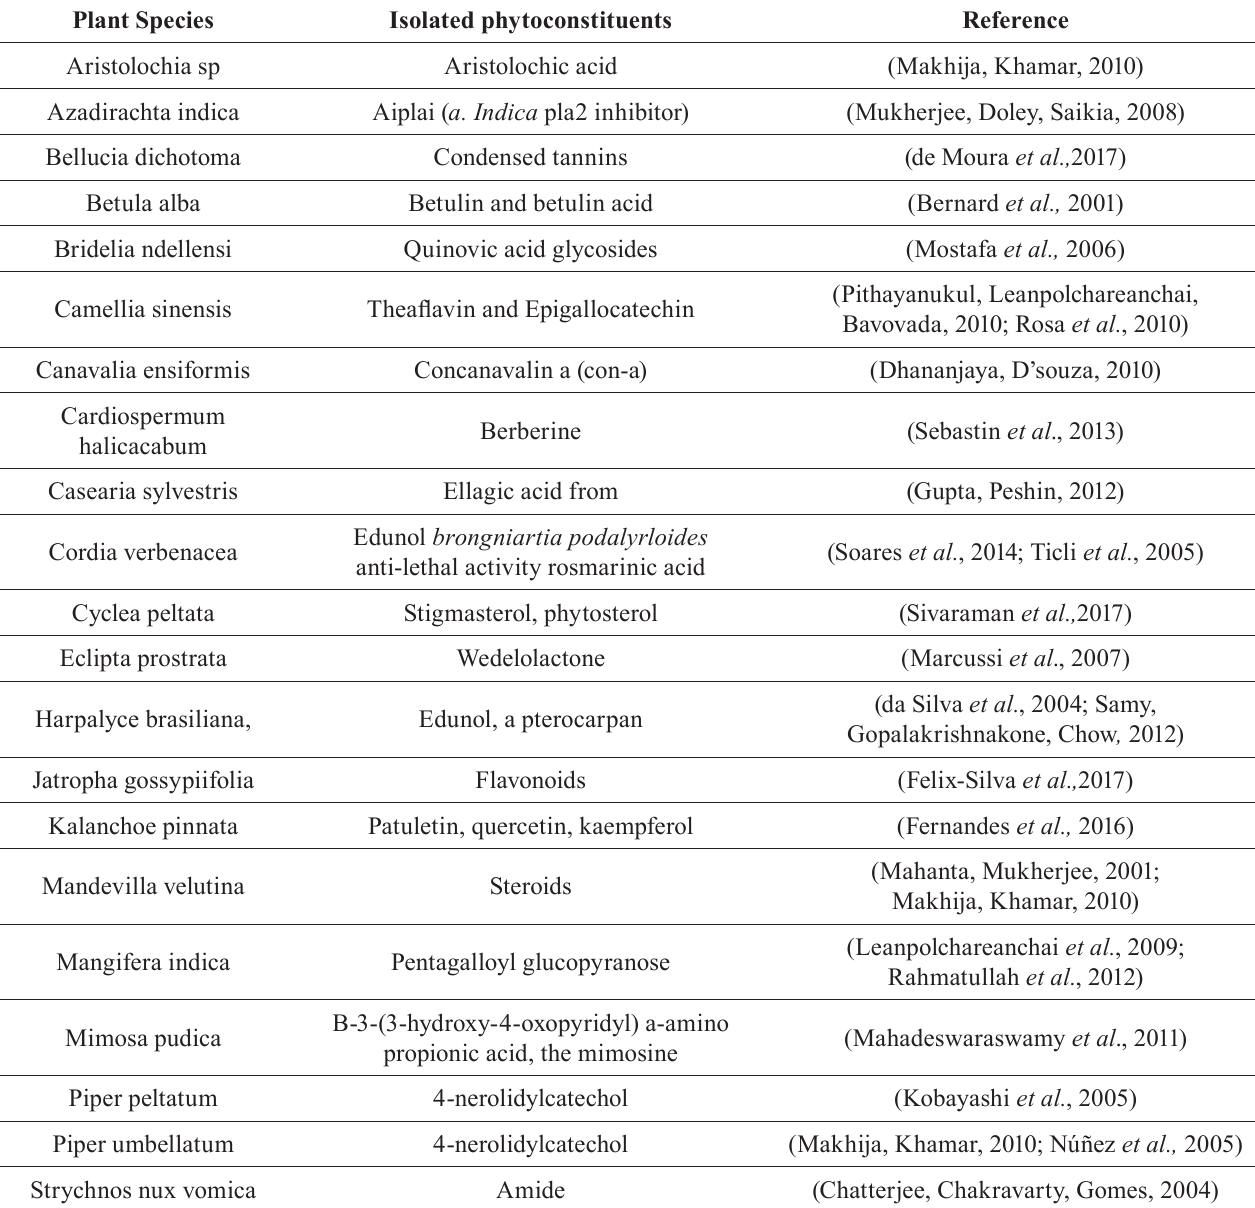
TABLE III - Phytoconstituents of traditional plants with antivenom activity Plant